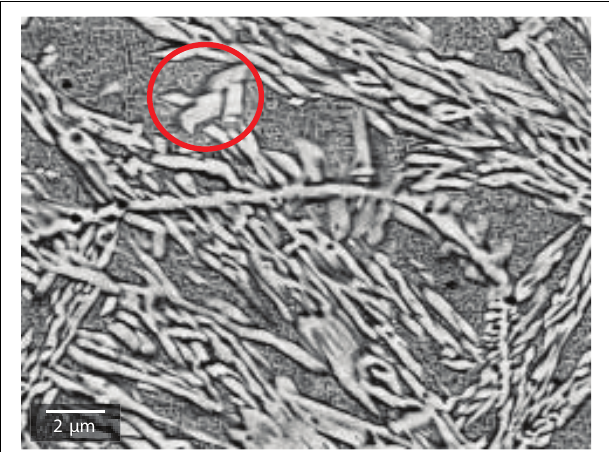
FIGURE 7 | SEM image of laser material deposition (LMD) fabricated B sample with 450 ◦ C pre-heating at the vicinity of the interlayer region in as-built condition. FCC platelets (exemplified inside red circle) and Widmanst a tten-like structures over a BCC/(B2) nano-scale compositionally de-mixed matrix are visible.